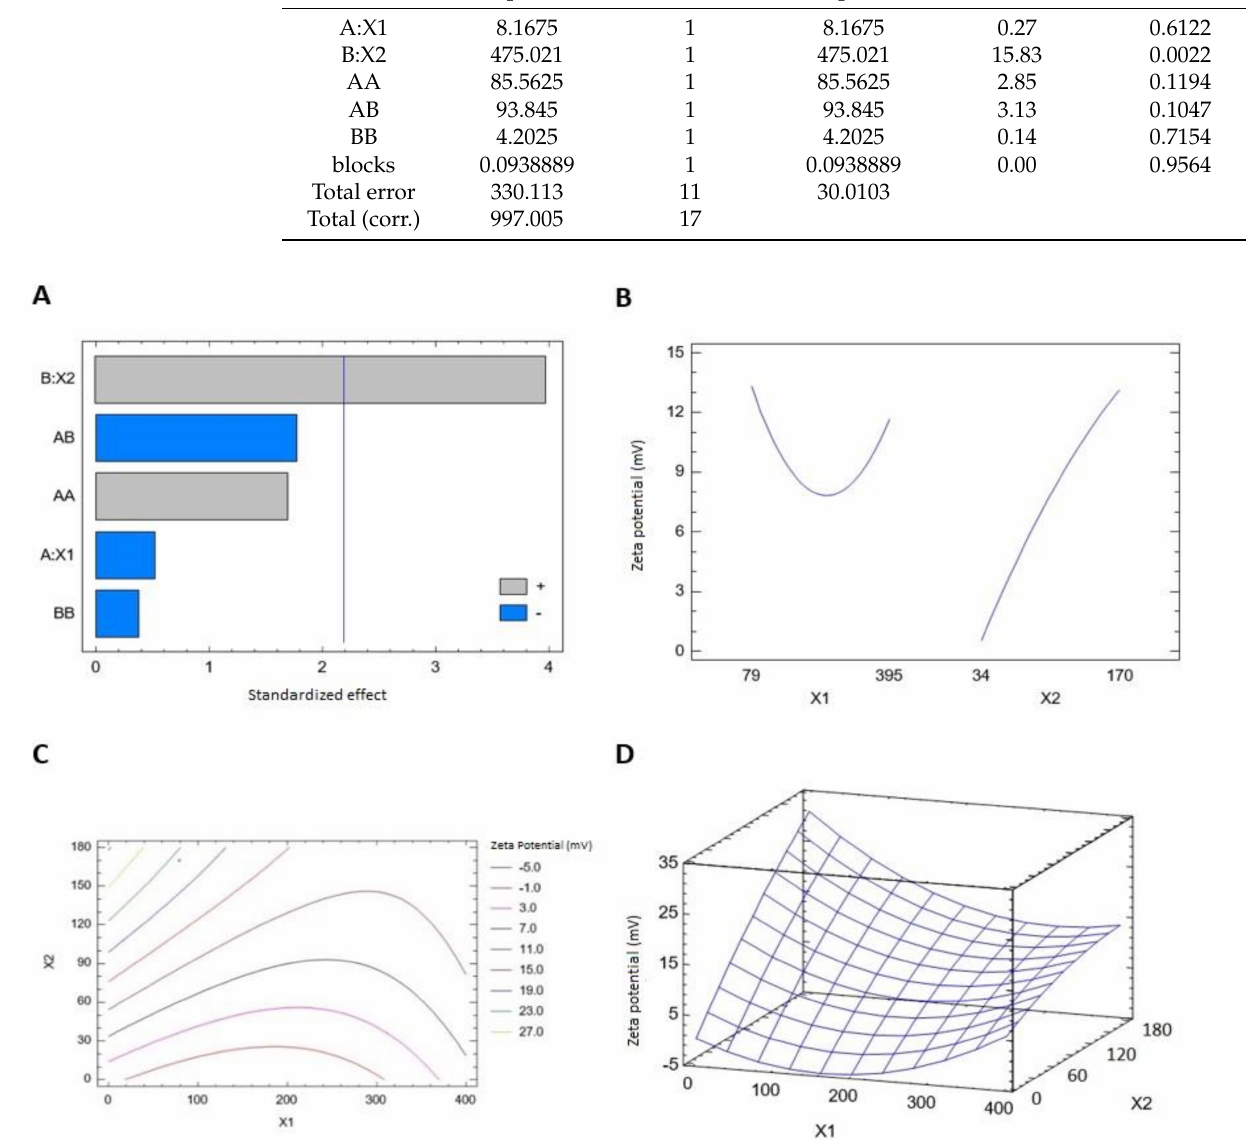
Figure 2. Standardized pareto chart ( A ), main effects plot ( B ), contour 2D plot ( C ) and response 3D plot ( D ) showing the effects and interaction between PL and SV amounts on the zeta potential of THQ–PL–SV phytosomes. Abbreviations: THQ, thymoquinone; PL, Phospholipon ® 90H; SV, scorpion venom